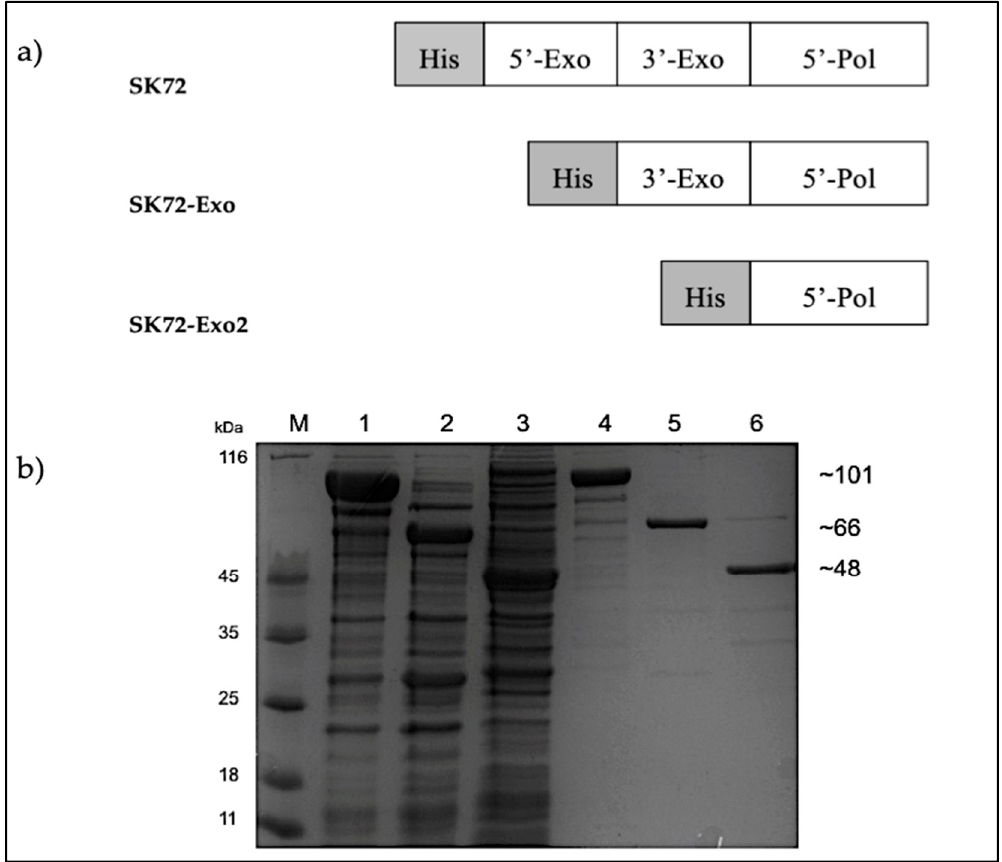
Figure 3. The SK72 DNA polymerase I and its variants. ( a ) Schematic representation of SK72 DNA polymerase I and its variants fused with a polyhistidine tag. ( b ) Expression and purification of SK72 DNA polymerase I and its variants. The overexpressed (lane 1 to 3) and purified (lane 4 to 6) of SK72 DNA polymerase I and its variants. Note: SK72 (lanes 1 and 4), SK72-Exo (lanes 2 and 5), SK72-Exo2 (lanes 3 and 6), and M = unstained protein marker (Thermo Fisher, City, Waltham, MA, , USA).